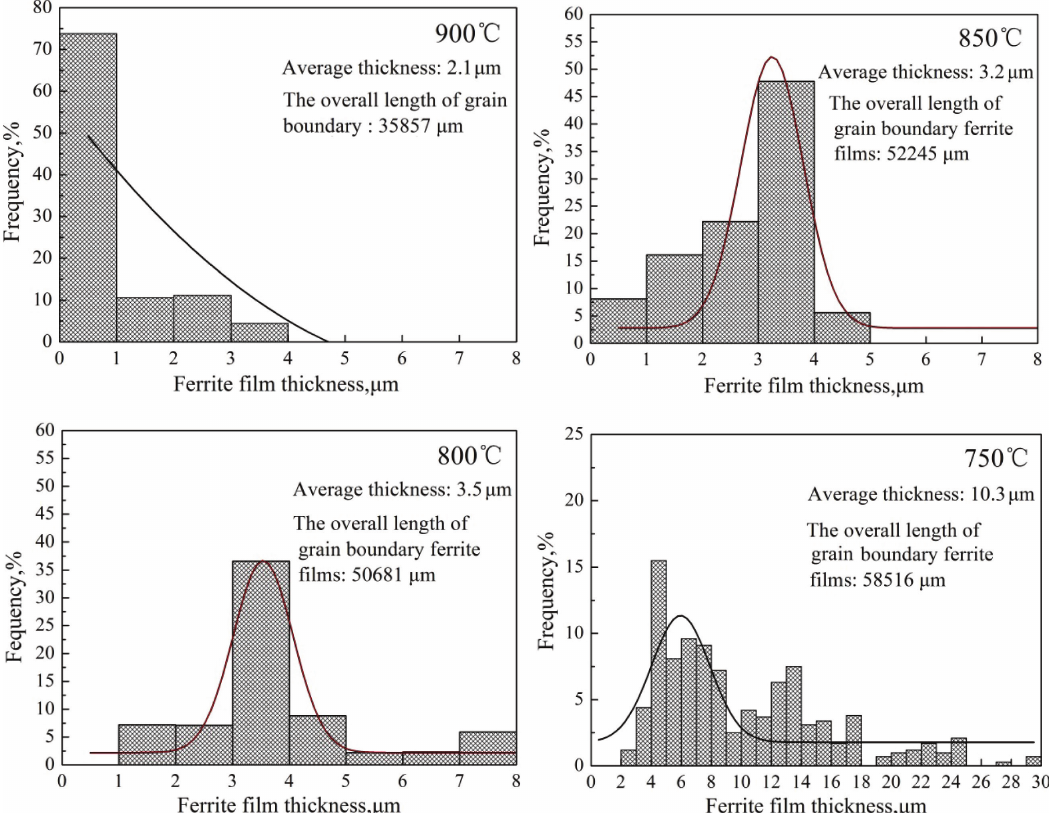
Fig. 6: Frequency of ferrite films as a function of temperature in Ti-bearing